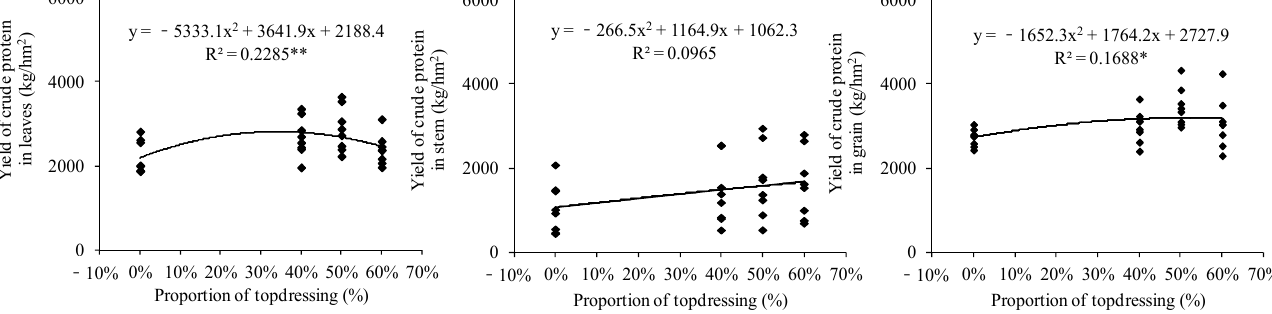
Figure 15. Relationship between crude protein yield and fertilization method for 75,000 plants per ha − 1 . Note: “*” and “**” indicate the significant correlation at the 0.05 and 0.01 probability level, respectively. The dots represent the measured values, and the lines represent the correlation trend in the figure.